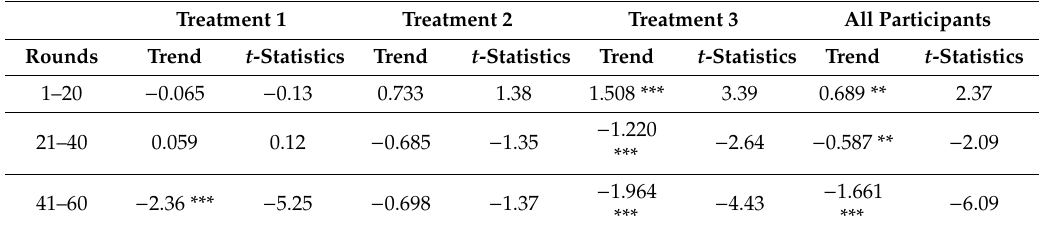
Table 4. Trend in round groups and di ff erent treatments (individual fixed e ff ects). Dependent variable: tax payments.